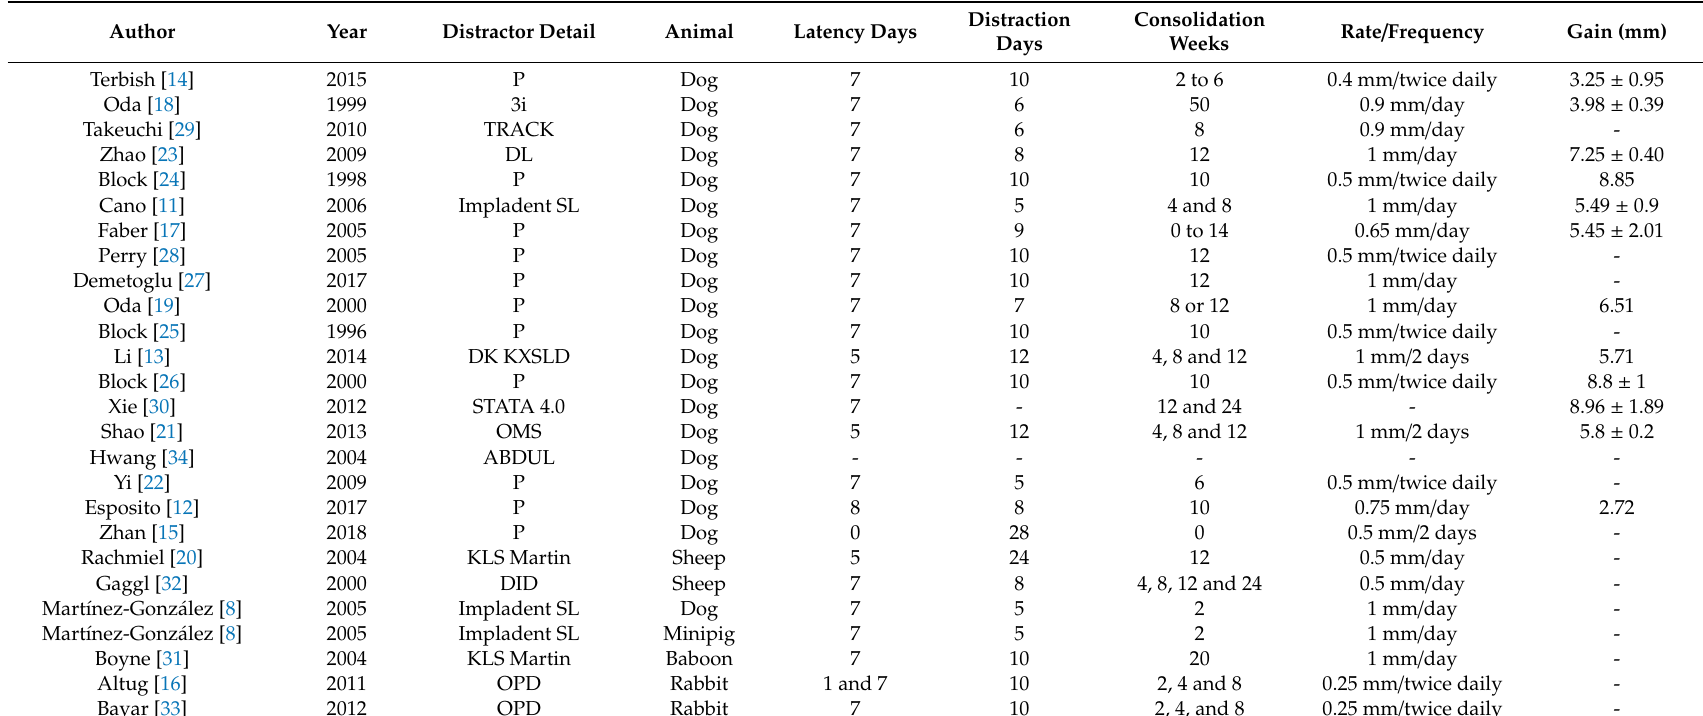
Table 3. Distraction protocol details of each